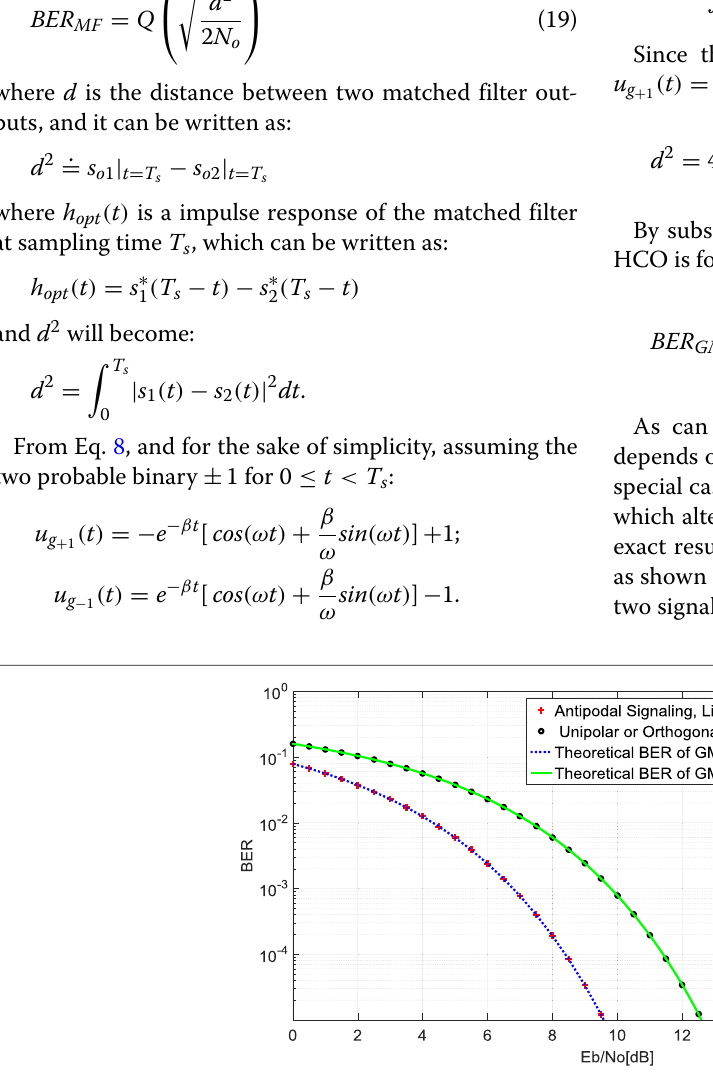
In the case of a matched filter, after optimizing Eq. 18,